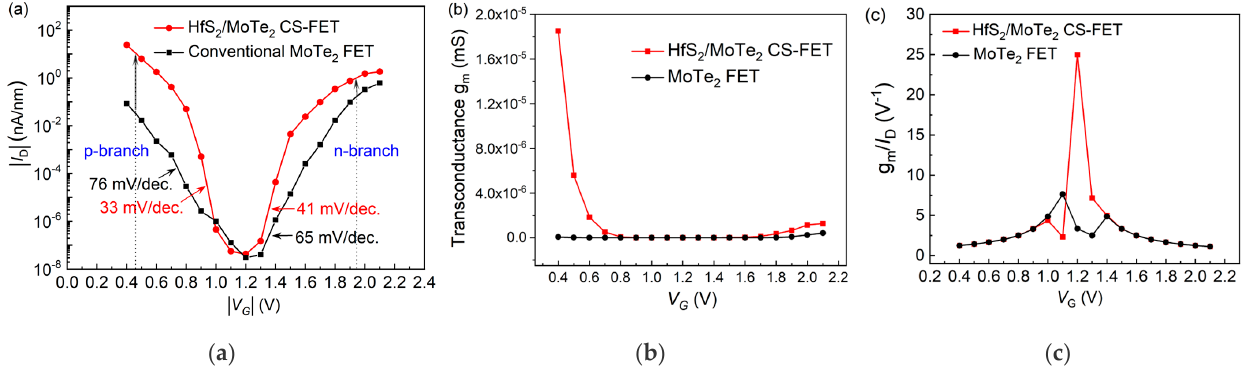
Figure 3. ( a ) Current-voltage transfer characteristics, ( b ) transconductance and ( c ) transconductance efficiency of MoTe 2 FETs with and without HfS 2 contact at different gate voltages, | V SD | = 0.74